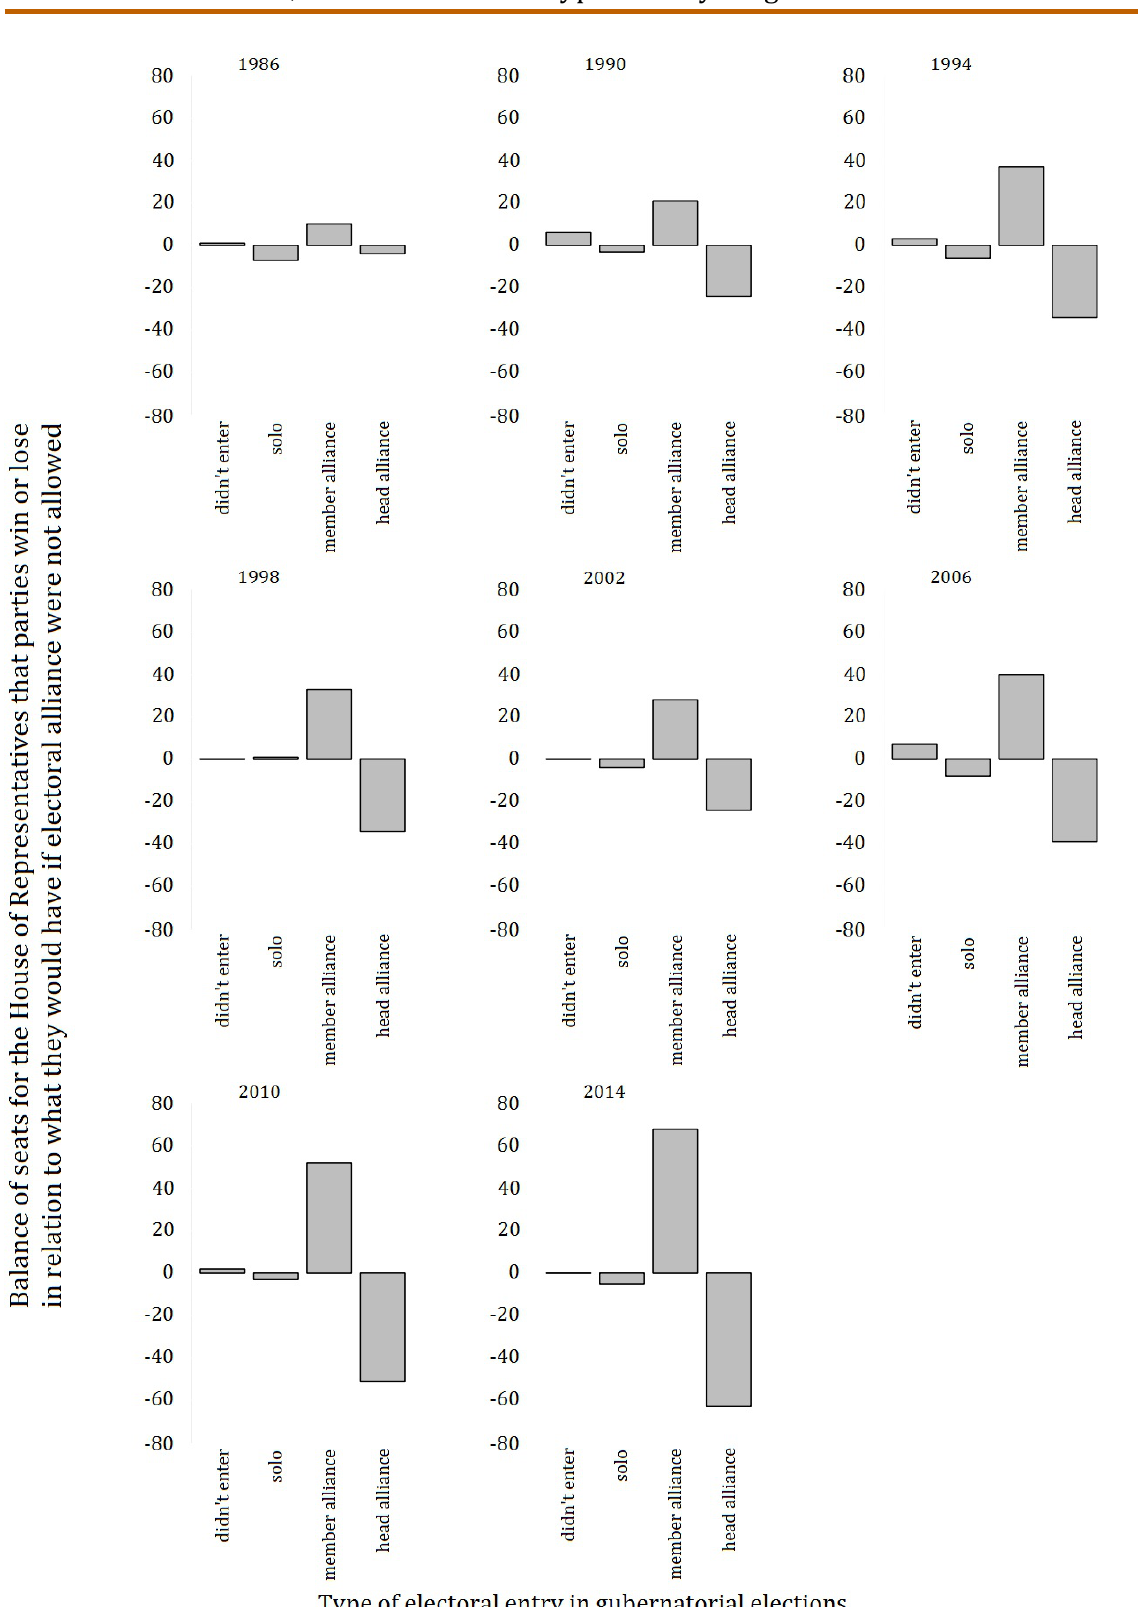
Graph 6. Number of seats redistributed if electoral alliances for the House of Representa- tives were not allowed, in accordance with type of entry for